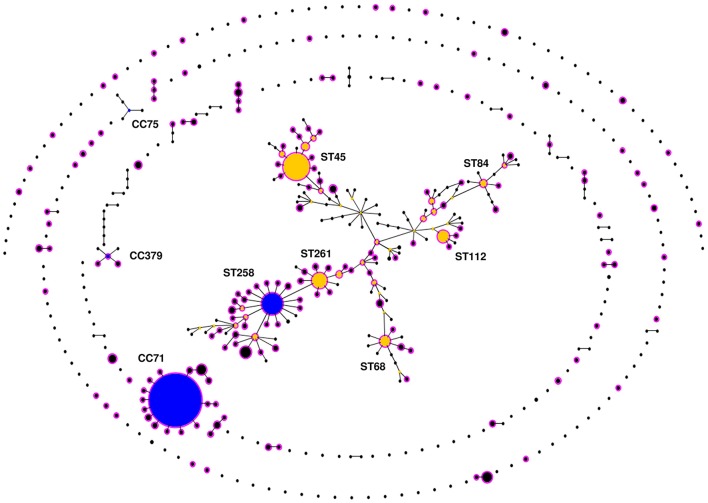
eBURST population snapshot of Staphylococcus pseudintermedius. Clusters of linked isolates correspond to clonal complexes (CCs). Primary founders (blue) are positioned centrally in the clusters, and subgroup founders are shown in yellow. The diameter of the circles is directly proportional to the total number of isolates reported in the MLST database (http://pubmlst.org/spseudintermedius/) and in reviewed scientific papers given in Table S1. Names of various important STs associated with methicillin resistance are indicated within a large, “straggly” CC, CC258. Methicillin resistant S. pseudintermedius (MRSP) lineages are highlighted in pink.